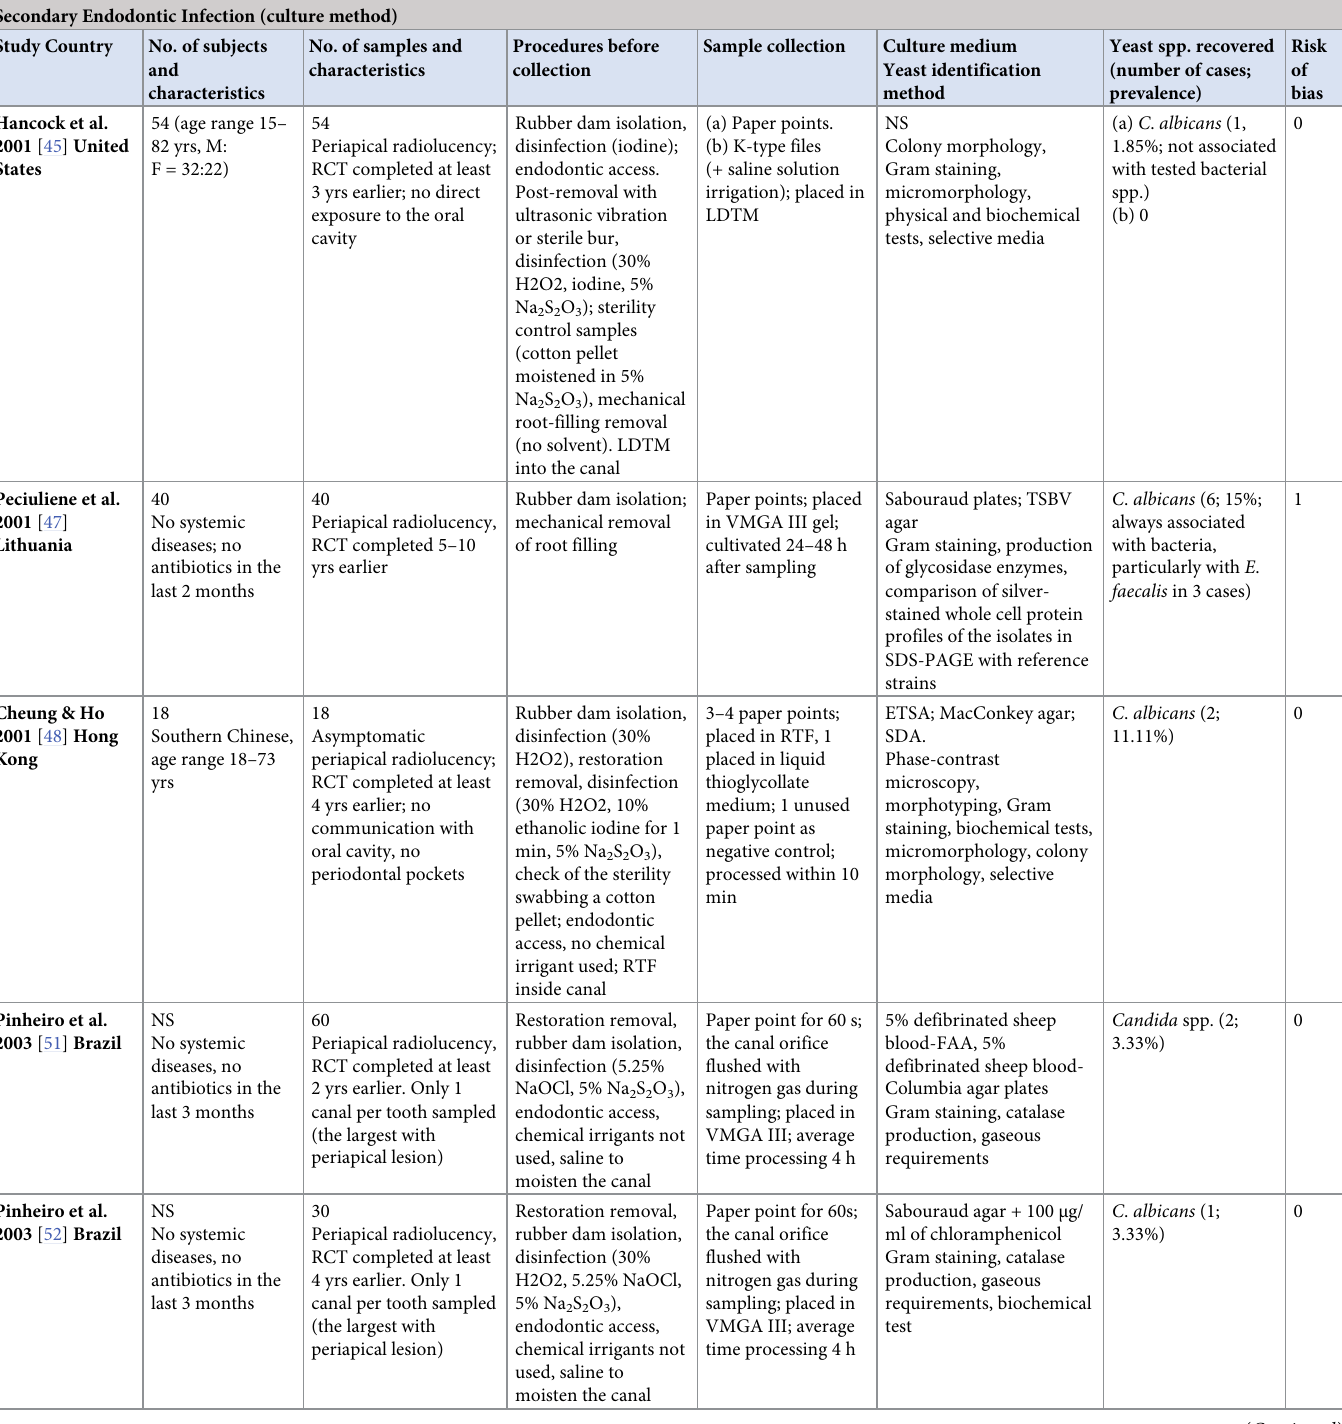
Table 2. Characteristics of the included studies using only culture methods for yeast identification, from secondary endodontic